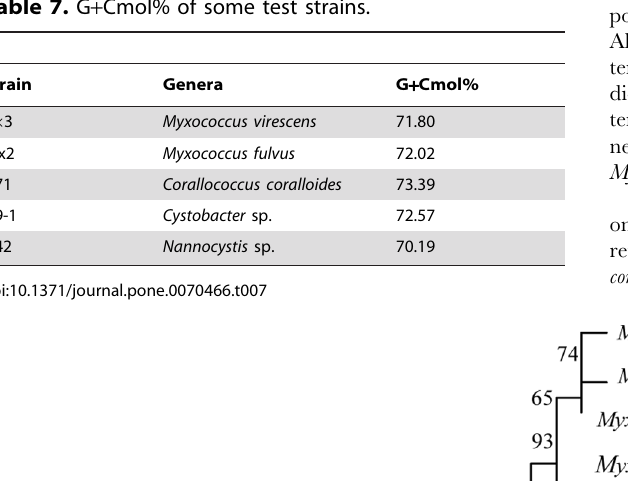
Table 7. G + Cmol% of some test strains.